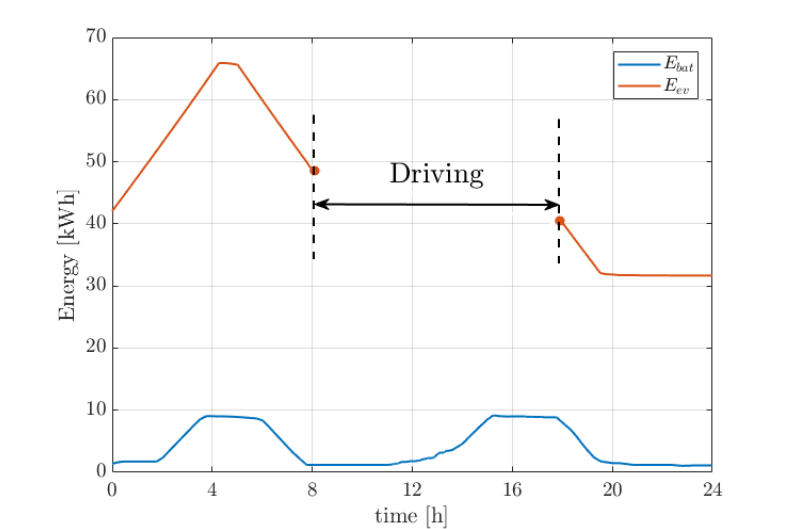
Figure 9. Resulting charge from optimized power flows inside electric vehicle and stationary storage for a summer